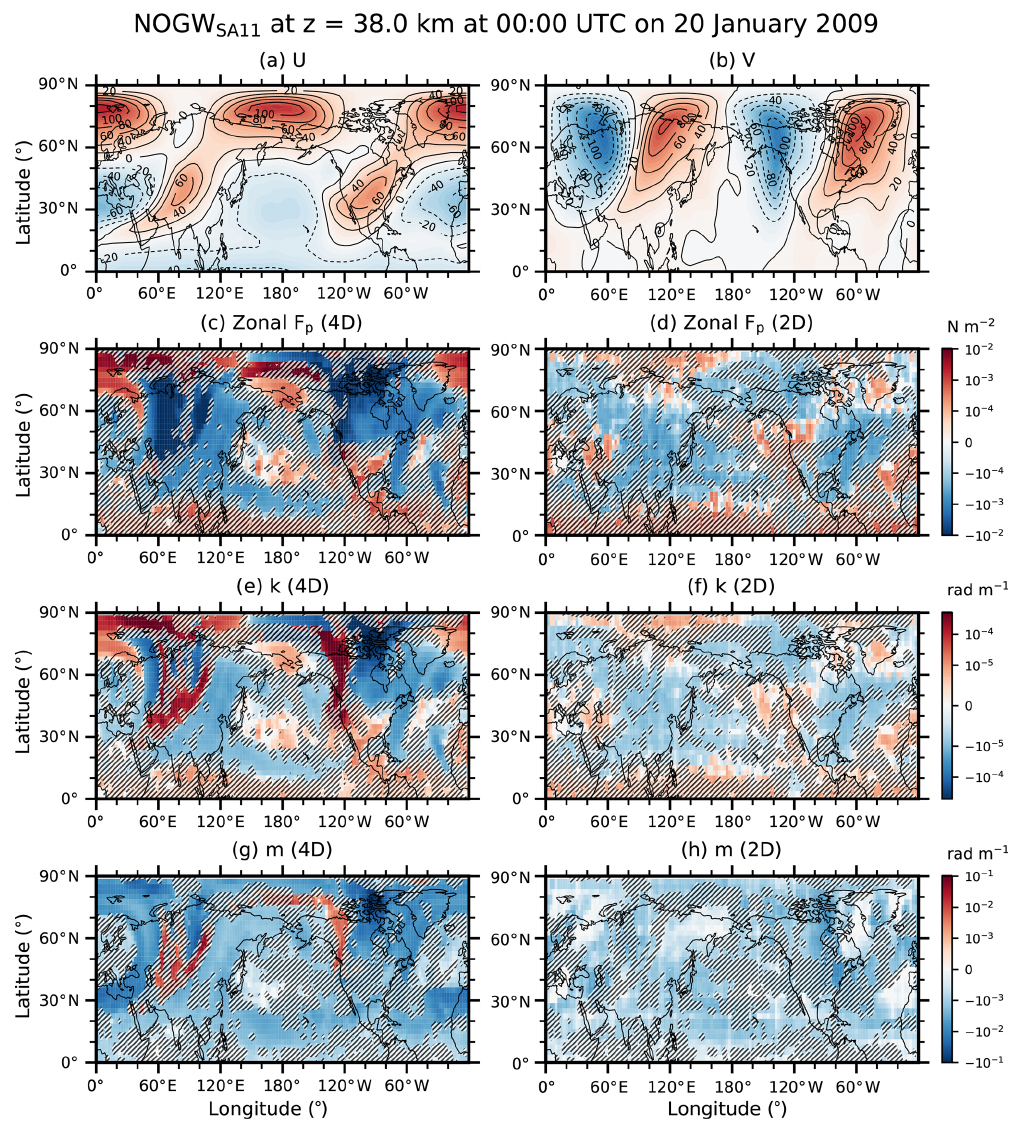
Figure 10. Same as Fig. 9 except for NOGW SA11